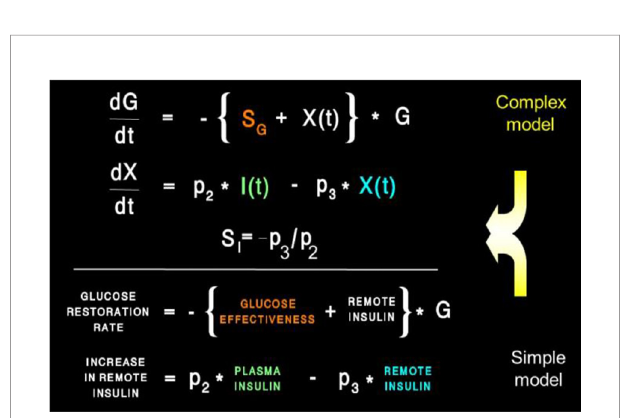
FIGURE 8 | Equations of the minimal model and their “ translation. ”